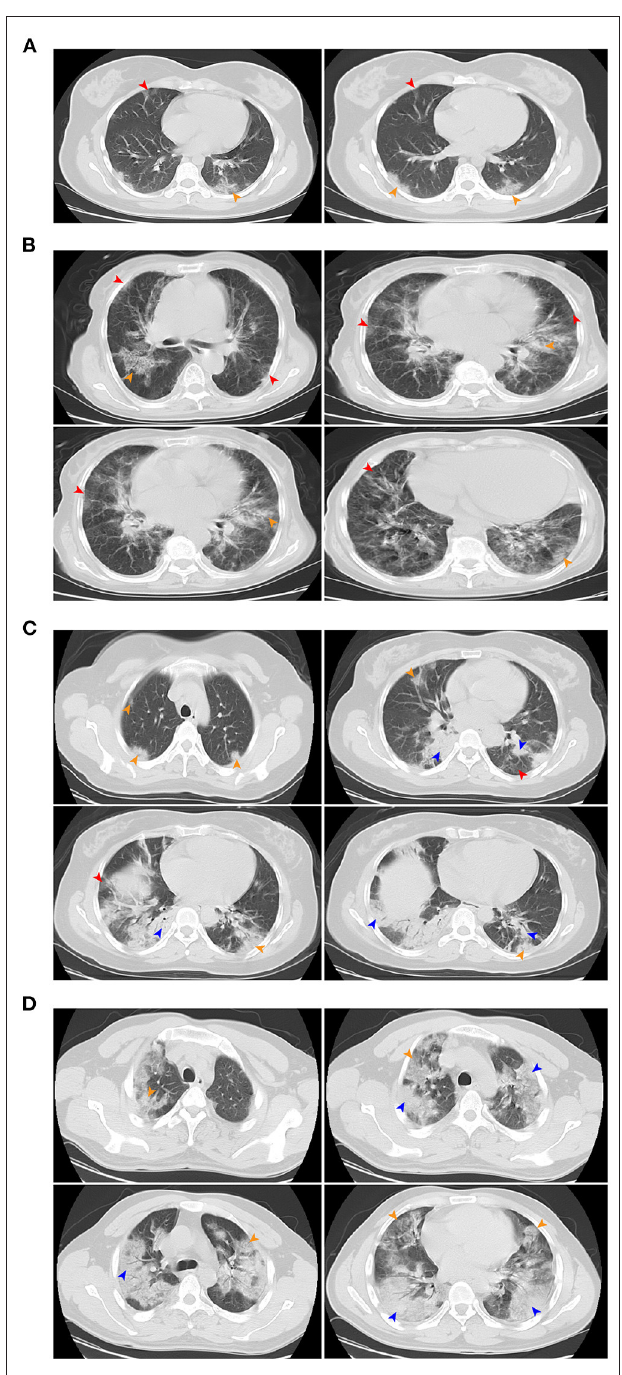
FIGURE 4 | Chest CT images. (A) Chest CT images showing bilateral ground-glass opacity on day 5 after symptom onset. (B) Chest CT images showing bilateral ground-glass opacity on day 3 after symptom onset. (C) Chest CT images showing bilateral ground-glass opacity and bilateral subsegmental areas of consolidation on day 5 after symptom onset. (D) Chest CT images showing bilateral multiple lobular and subsegmental areas of consolidation on day 10 after symptom onset. (A,B) were mild pneumonia, (C,D) were severe pneumonia. Red arrow indicates ground-glass opacity, yellow arrow indicates nodular consolidation, blue arrow indicates the mixture areas of ground-glass opacity and nodular